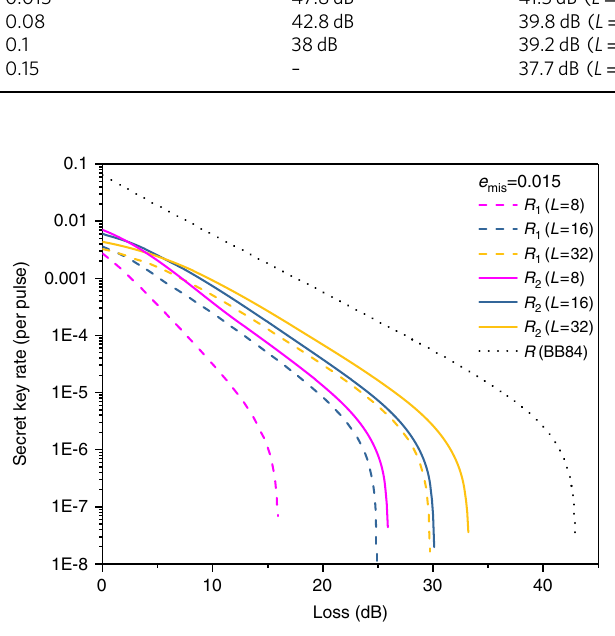
Fig. 2 Secret key rate R versus channel loss. R 1 and R 2 represent the original RRDPS protocol and the proposed one, respectively. The line for BB84 is not drawn since its key rate is always 0 in this case. Both R 1 and R 2 are simulated for the scenarios without monitoring signal